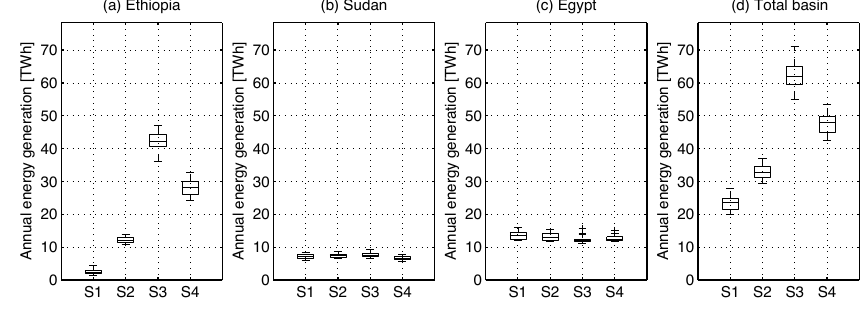
Fig. 9. Box-plots of annual hydropower generation, for the major countries of the basin and for each scenario.